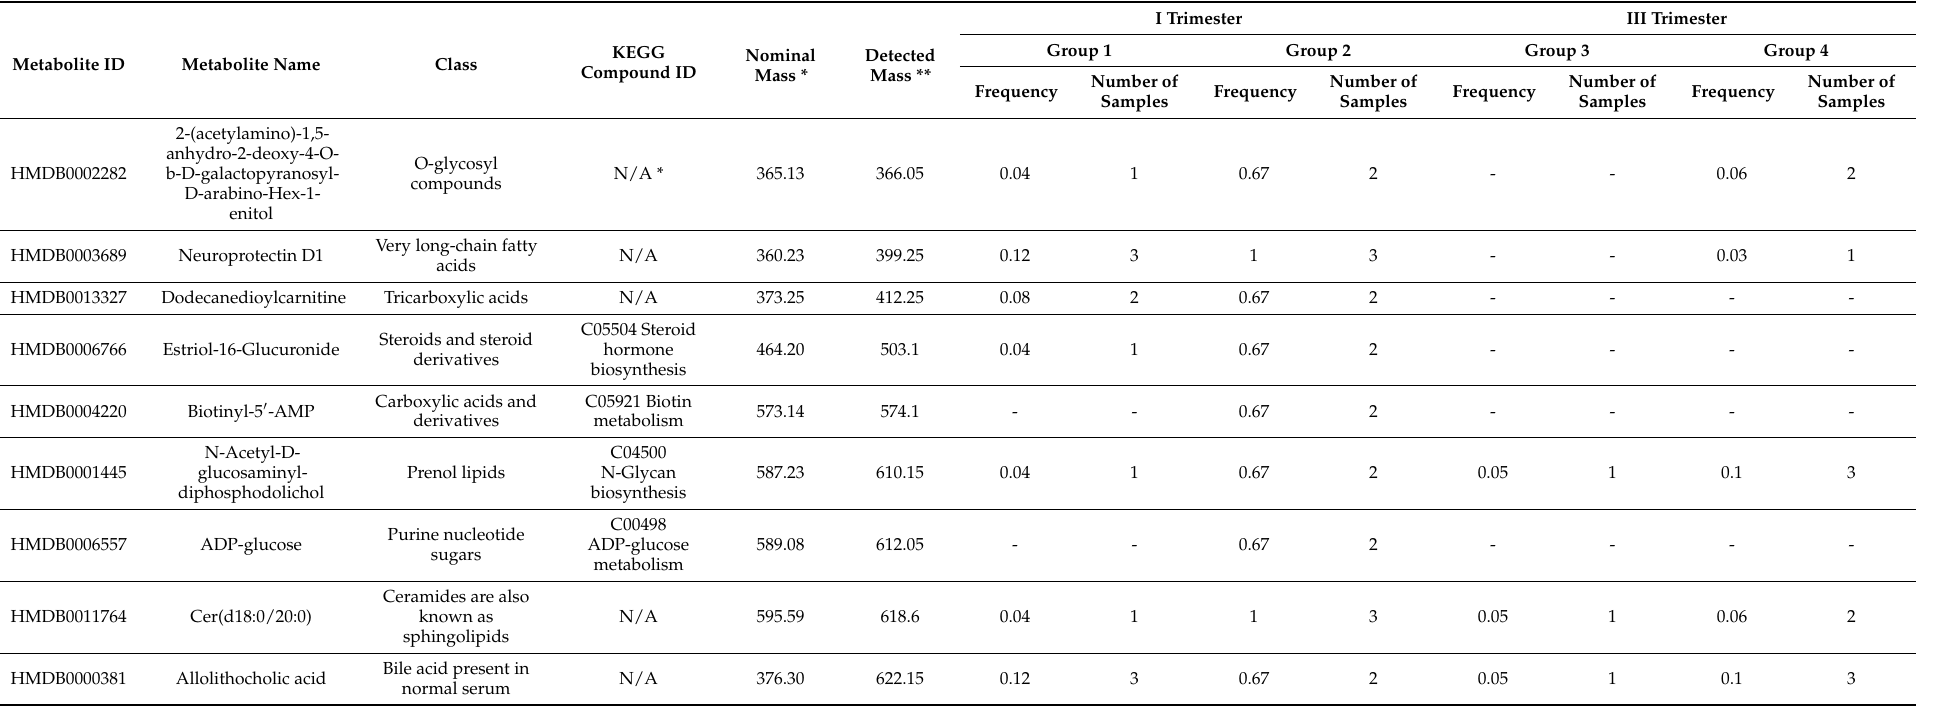
Table 2. Frequency of endogenous metabolites detected in blood plasma samples during normal pregnancy and complicated